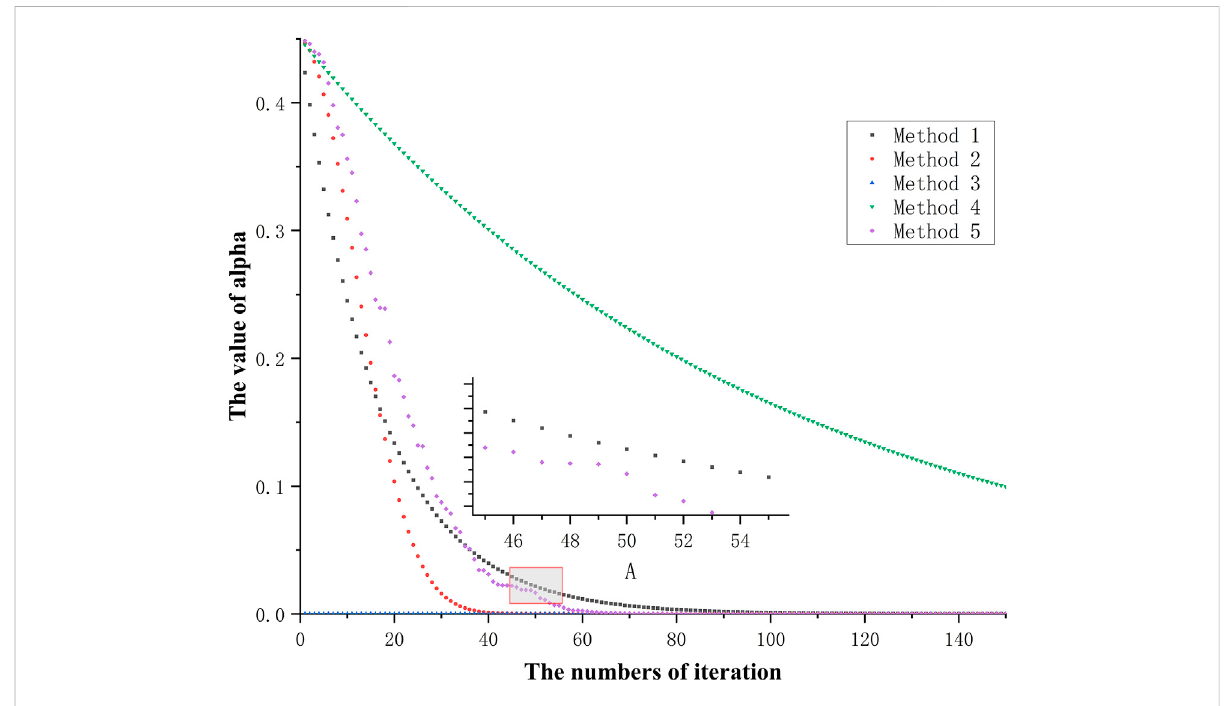
FIGURE 2 The iterated graph of alpha.